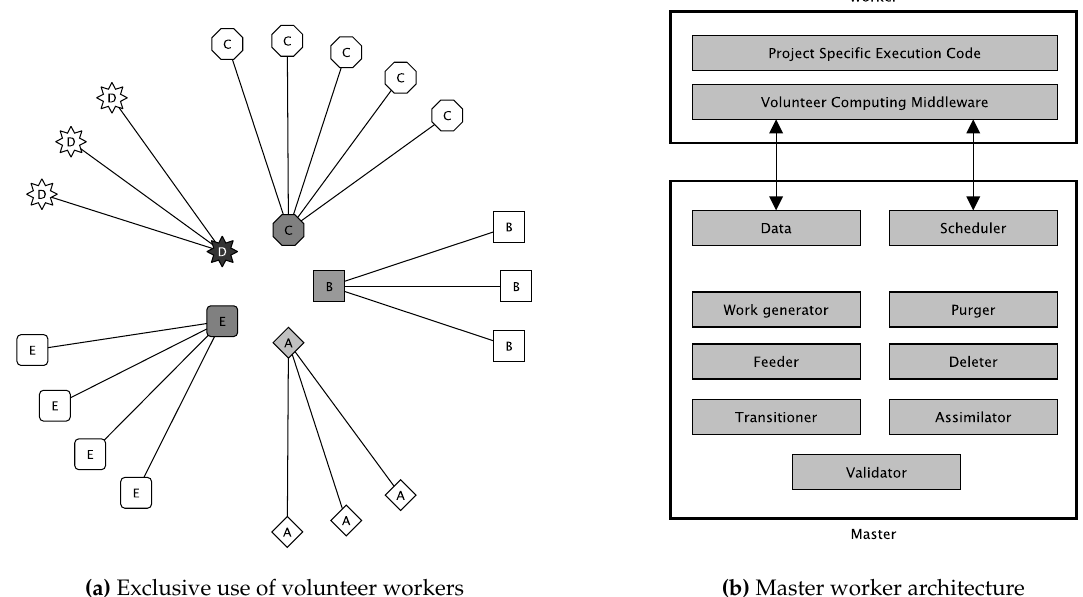
Figure 6. Common master worker model used by many VC